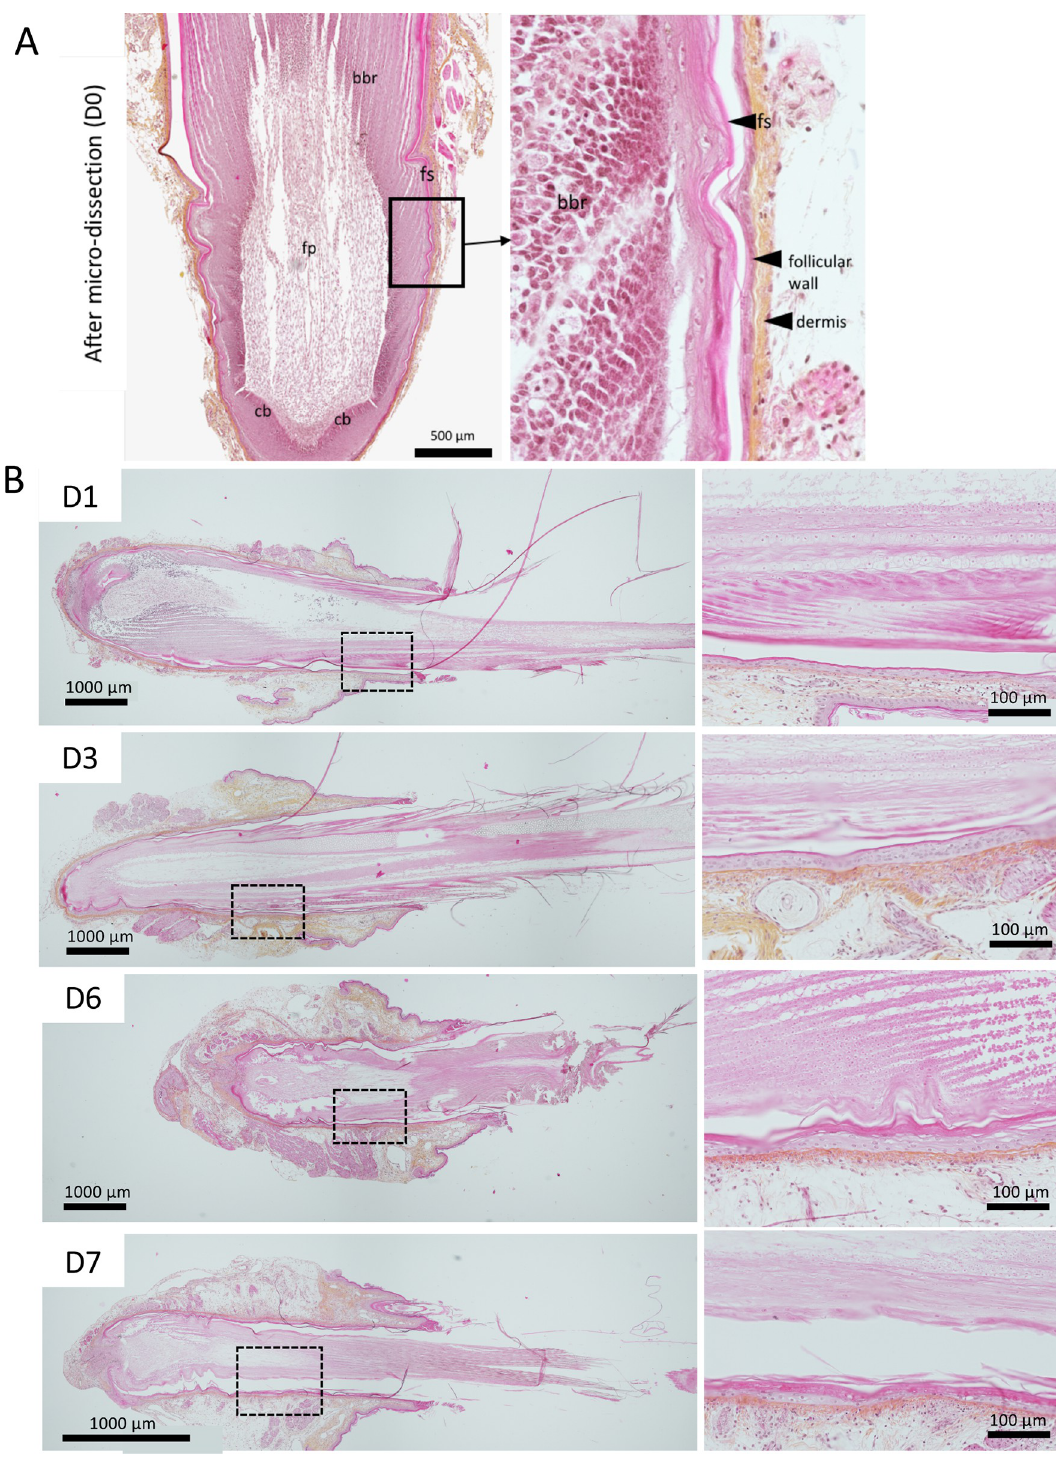
Fig 3. Histological structure of feather follicles from microdissection to Day 7 of in vitro cultivation. Formalin-fixed FFs embedded in paraffin were sectioned and stained with HES. (A) Overview of a typical FF with a growing feather after microdissection. bbr, barb ridges; cb, collar bulge; dermis; fs, feather sheath; follicular wall; fp, feather pulp. An enlargement of the barb ridges is shown. (B) Structure of FF after 1 (D1), 3 (D3), 6 (D6), and 7 (D7) days of cultivation in vitro . A low magnification showing the whole FF with its feather (left panels). An enlargement of the barb ridges (right